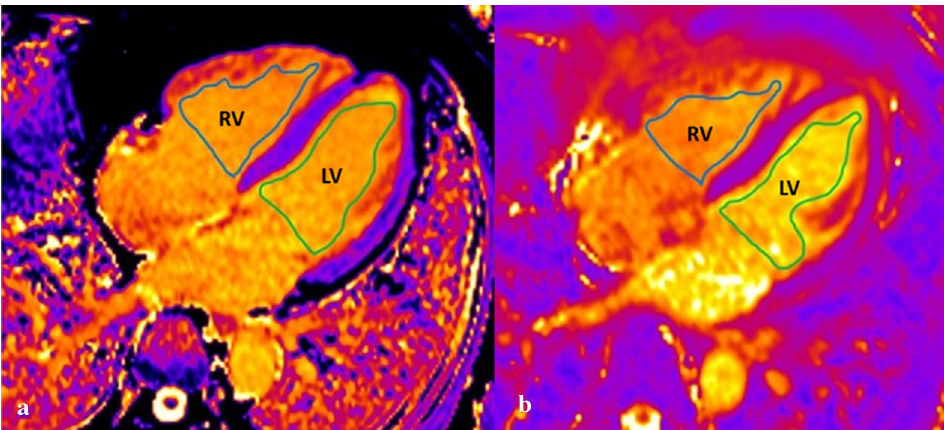
Fig. 1 Measurement of RV and LV blood pool T1 ( a ) and T2 ( b ) the 4-chamber cardiac view of T1 map and T2